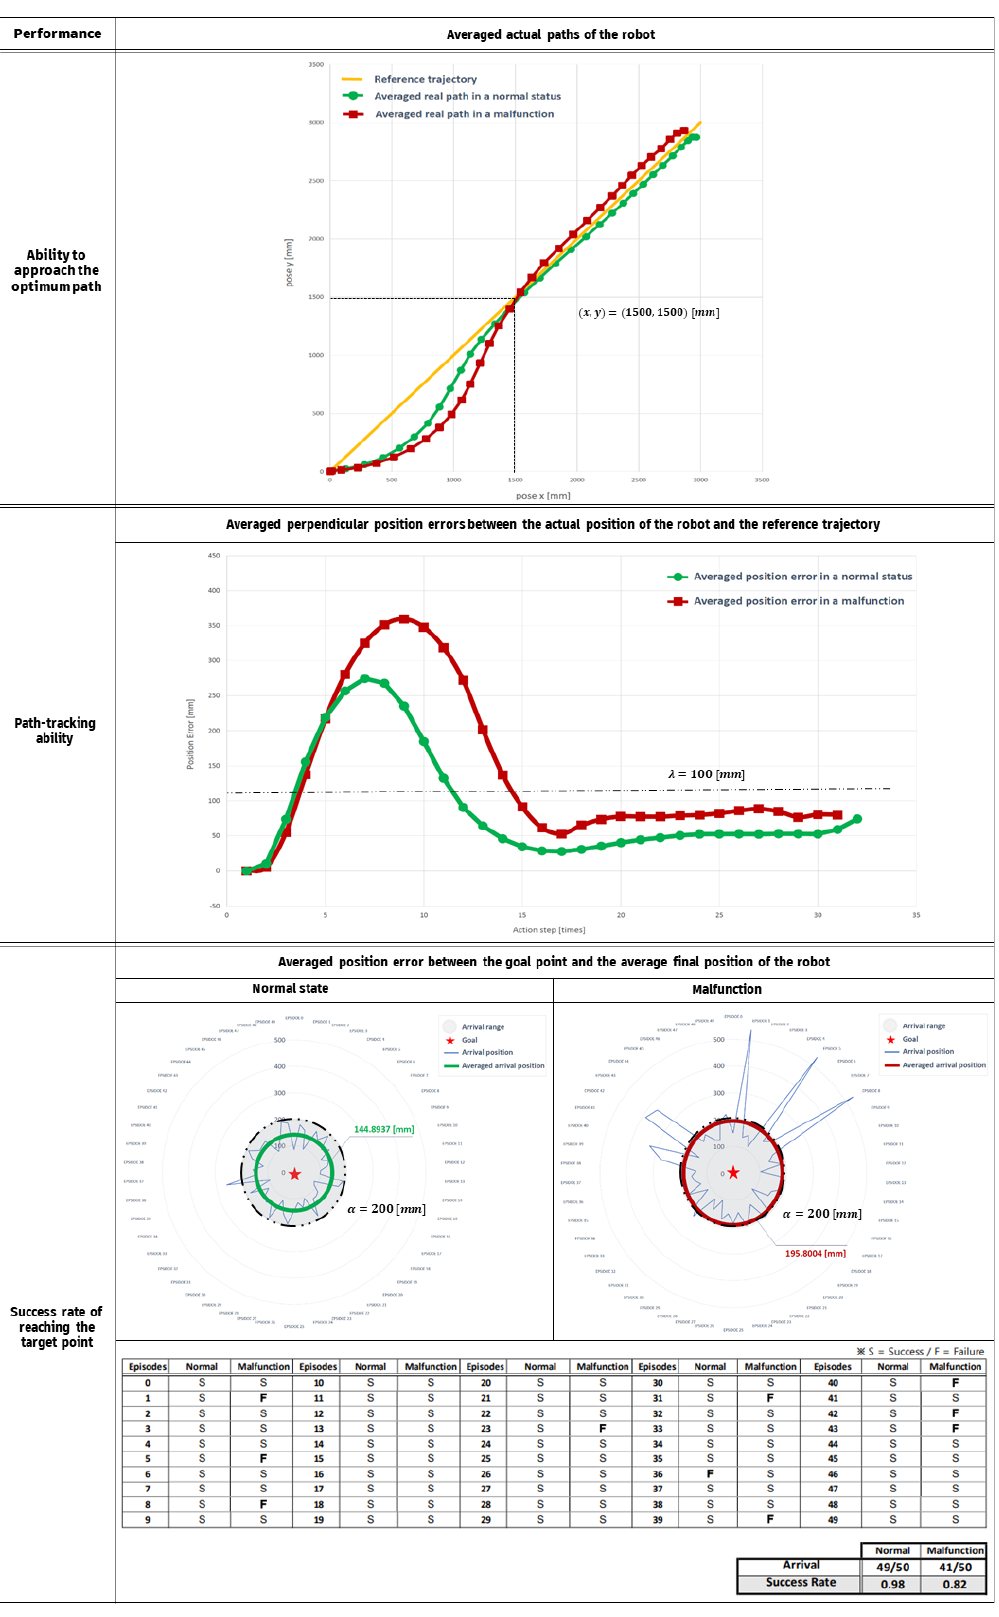
Figure 25. Quantitative analyses based on three performance criteria (thresholds) in motion plan- ning with the DQN. with the